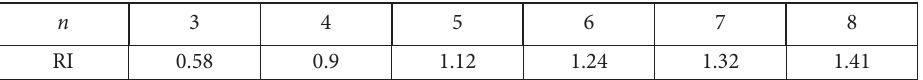
Table 4. Consistency indices for the randomly generated matrix (source: Saaty, 1980) n 3